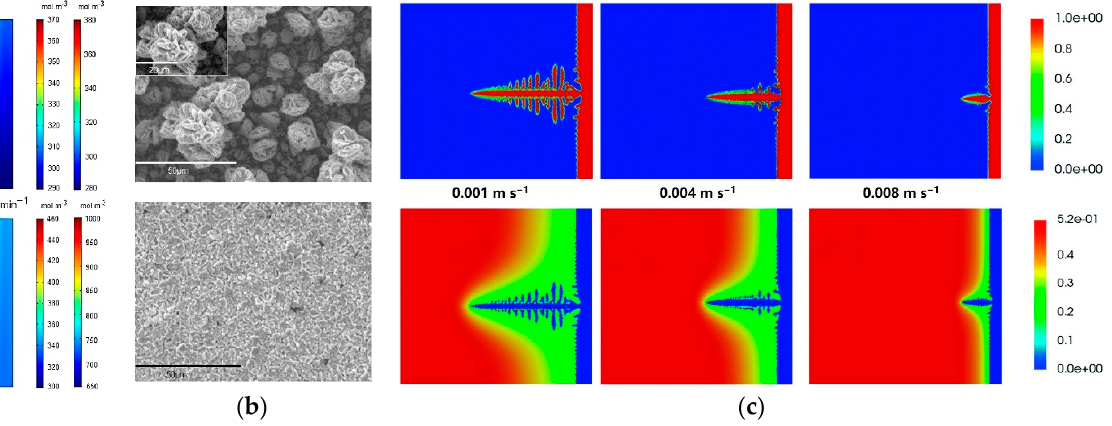
Figure 11. ( a ) The species distribution at different flow rates at the 50% stage during charge (up: left side is Zn(OH) 42 − , right side is Fe(CN) 63 − ) and discharge (down: left side is Zn(OH) 42 − , right side is Fe(CN) 64 − ). Reproduced with permission from [87]. Copyright 2021, Elsevier; ( b ) deposited zinc morphologies in weight 40% KOH with 1 M zinc oxide with electric quantity for 10 min at the cur- rent density of 100 mA cm − 2 : quiescent electrolyte (up) and flowing electrolyte (down). Repro- duced with permission from [101]. Copyright 2014, Elsevier; ( c ) dendrite morphology (up) and Zn(OH) 42 − concentration distribution (down) diagram at different flow rates (0.001 m ·s -1 , 0.004 m ·s - 1 , 0.008 m ·s -1 ) . Reproduced with permission from [78]. Copyright 2021, Royal Society of Chemis- try.